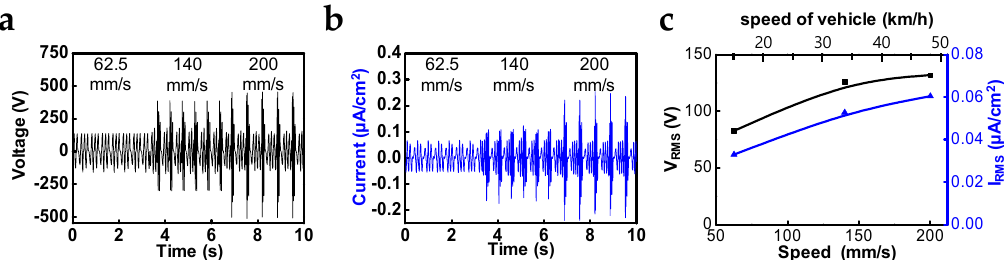
Figure 3. Output performance evaluation versus the different speeds of outer cylinder: ( a ) output voltage and ( b ) short-circuit current with speeds of 62.5, 140, 200 mm/s, respectively; ( c ) output voltage and short-circuit current in RMS value versus the speed of outer cylinder and the speed of a vehicle(expected from the speed of outer cylinder).